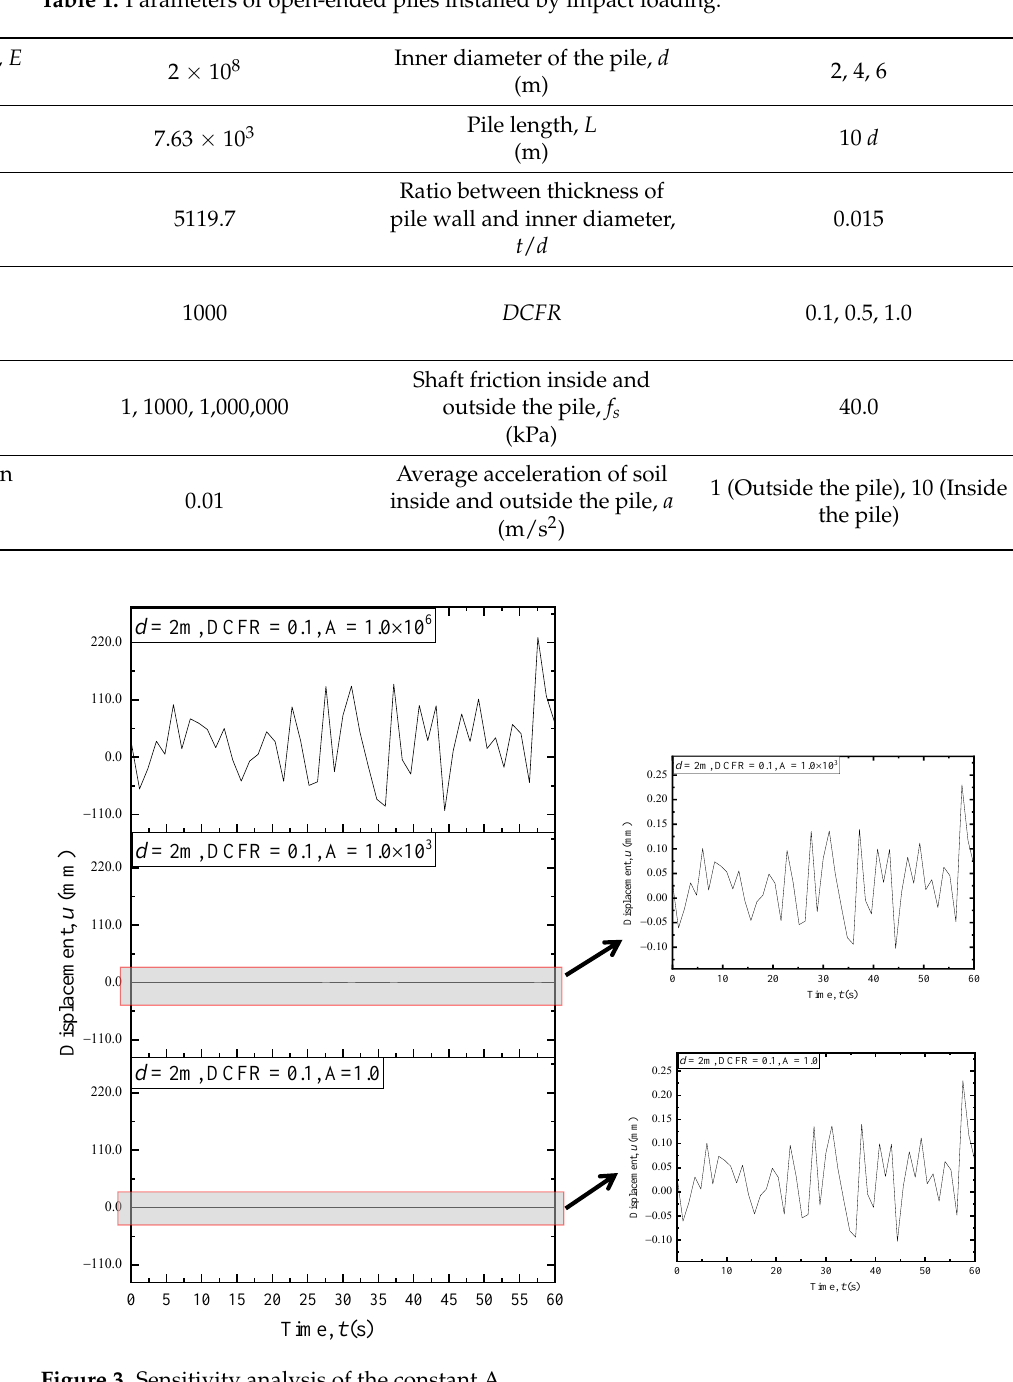
Table 1. Parameters of open-ended piles installed by impact loading.